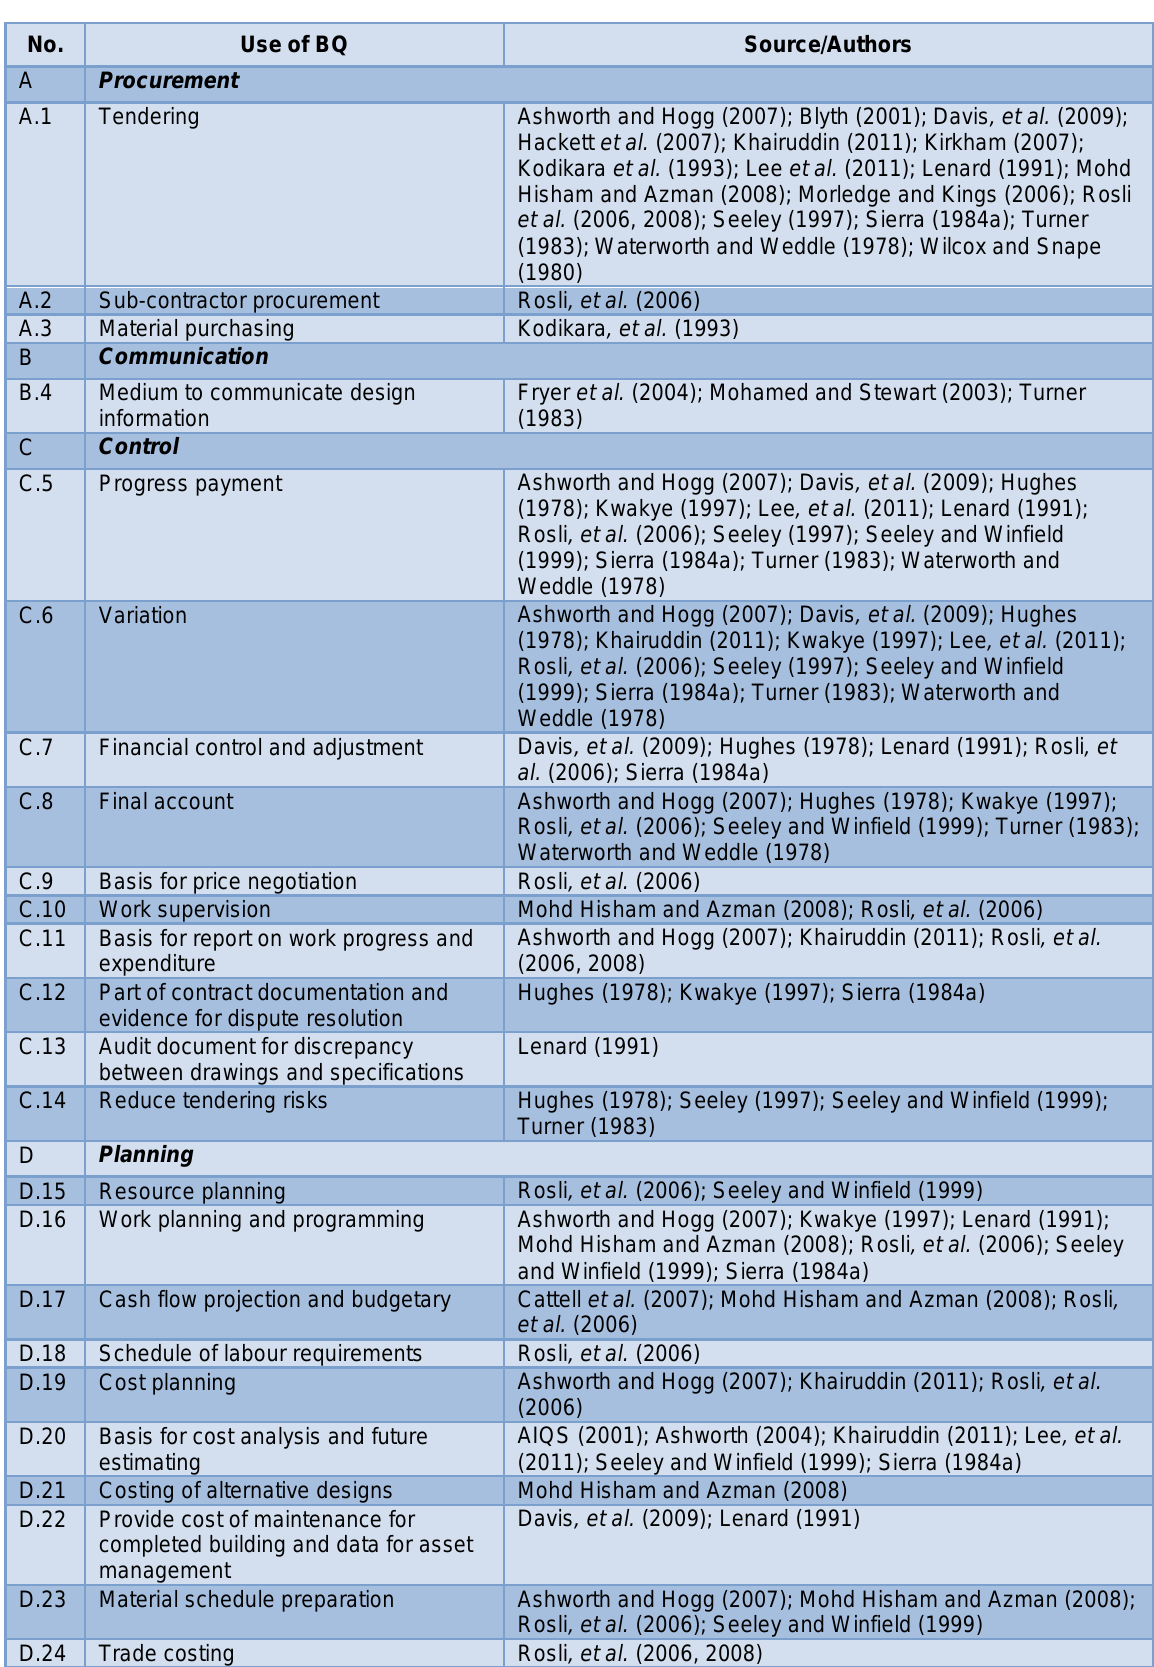
Table 1 The identified use of BQ in construction